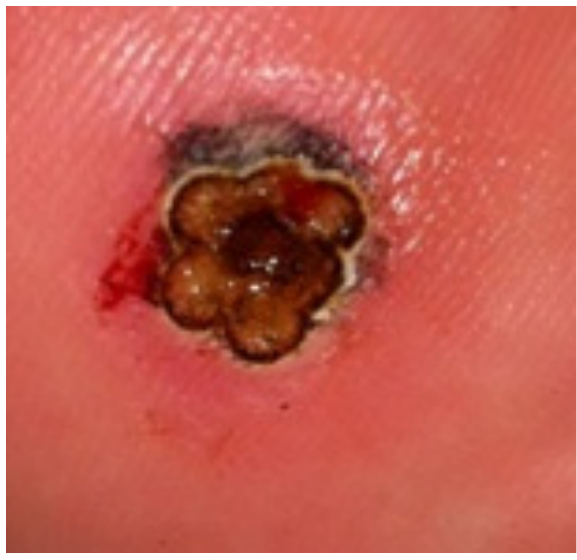
Figure 3. Plantar wart with a diameter >4 mm. Simulation of the distribution of the laser application zones ensuring coverage of the whole lesion.